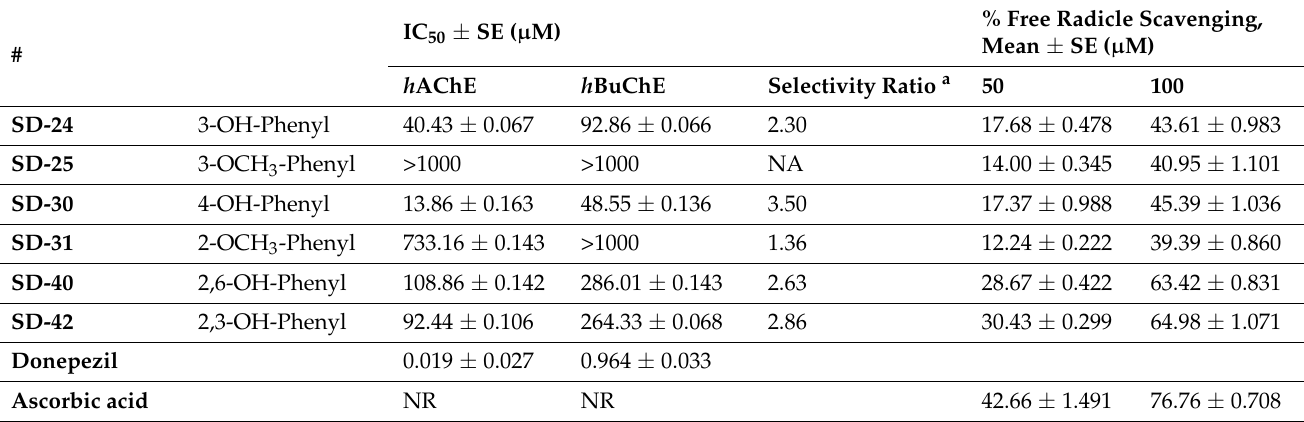
Table 1. Indene and indole analogues with their IC 50 for inhibitory activities against AchE, BuChE, and antioxidant activity.